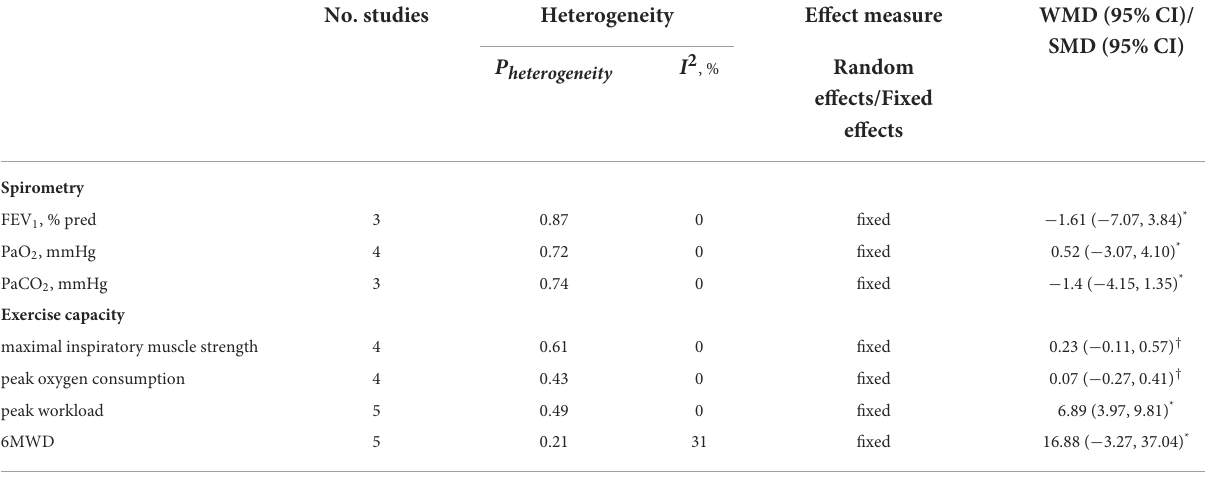
TABLE 2 The results of pooled meta-analysis on spirometry and exercise capacity.